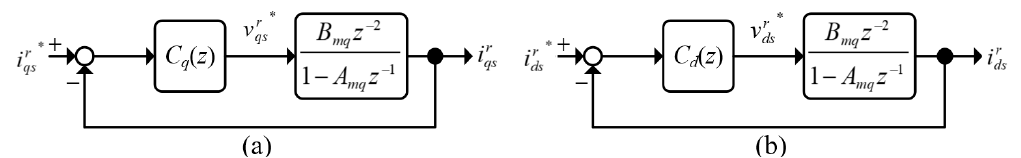
Figure 6. ( a ) q -axis and ( b ) d -axis current loop with the deadbeat controller when the motor is at standstill.